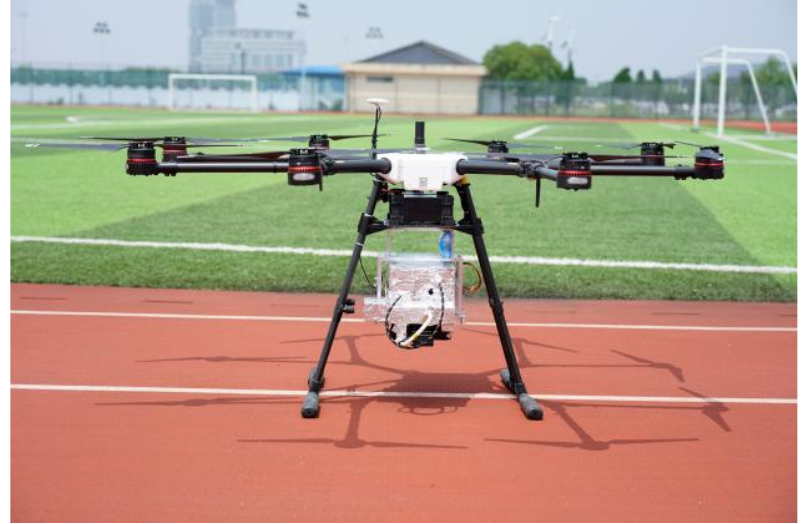
Figure 12. Instrument illustration.